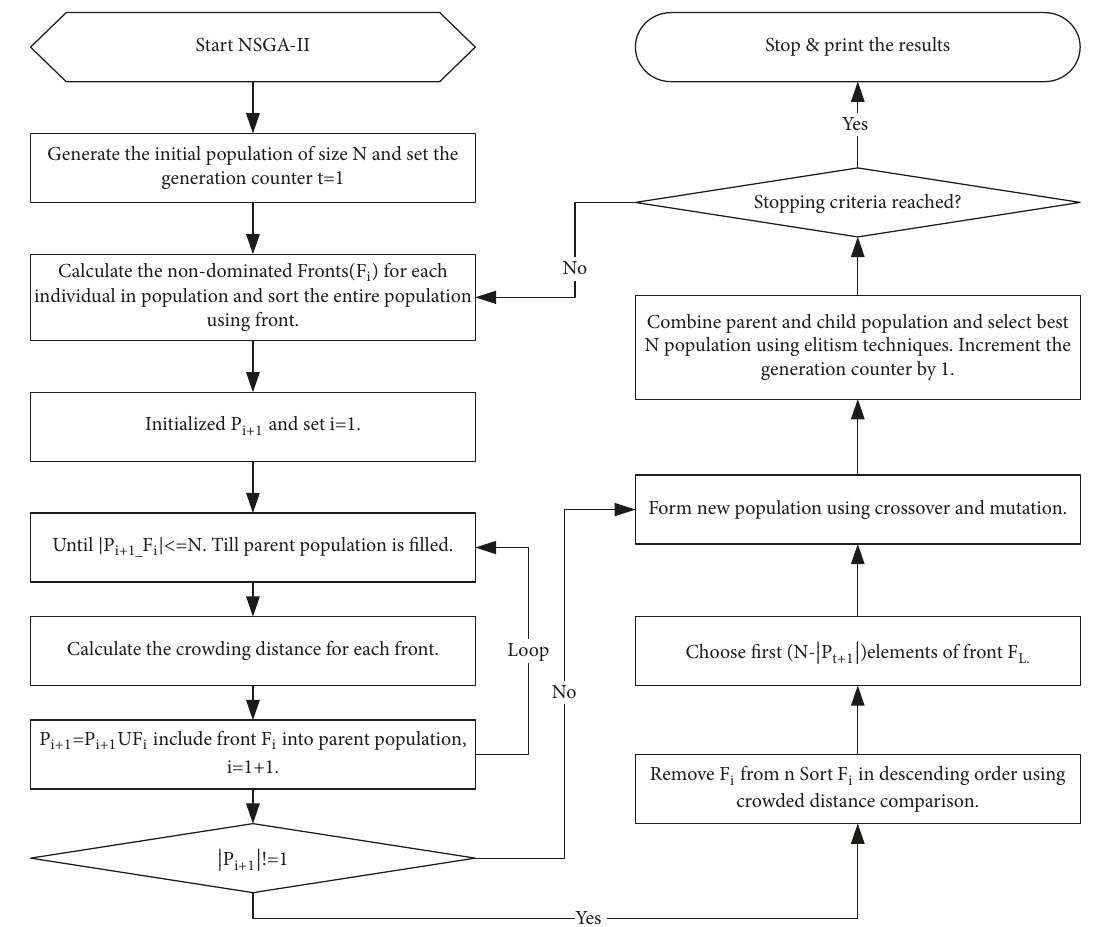
Figure 4: Flow chart of the solution algorithm based on NSGA-II.